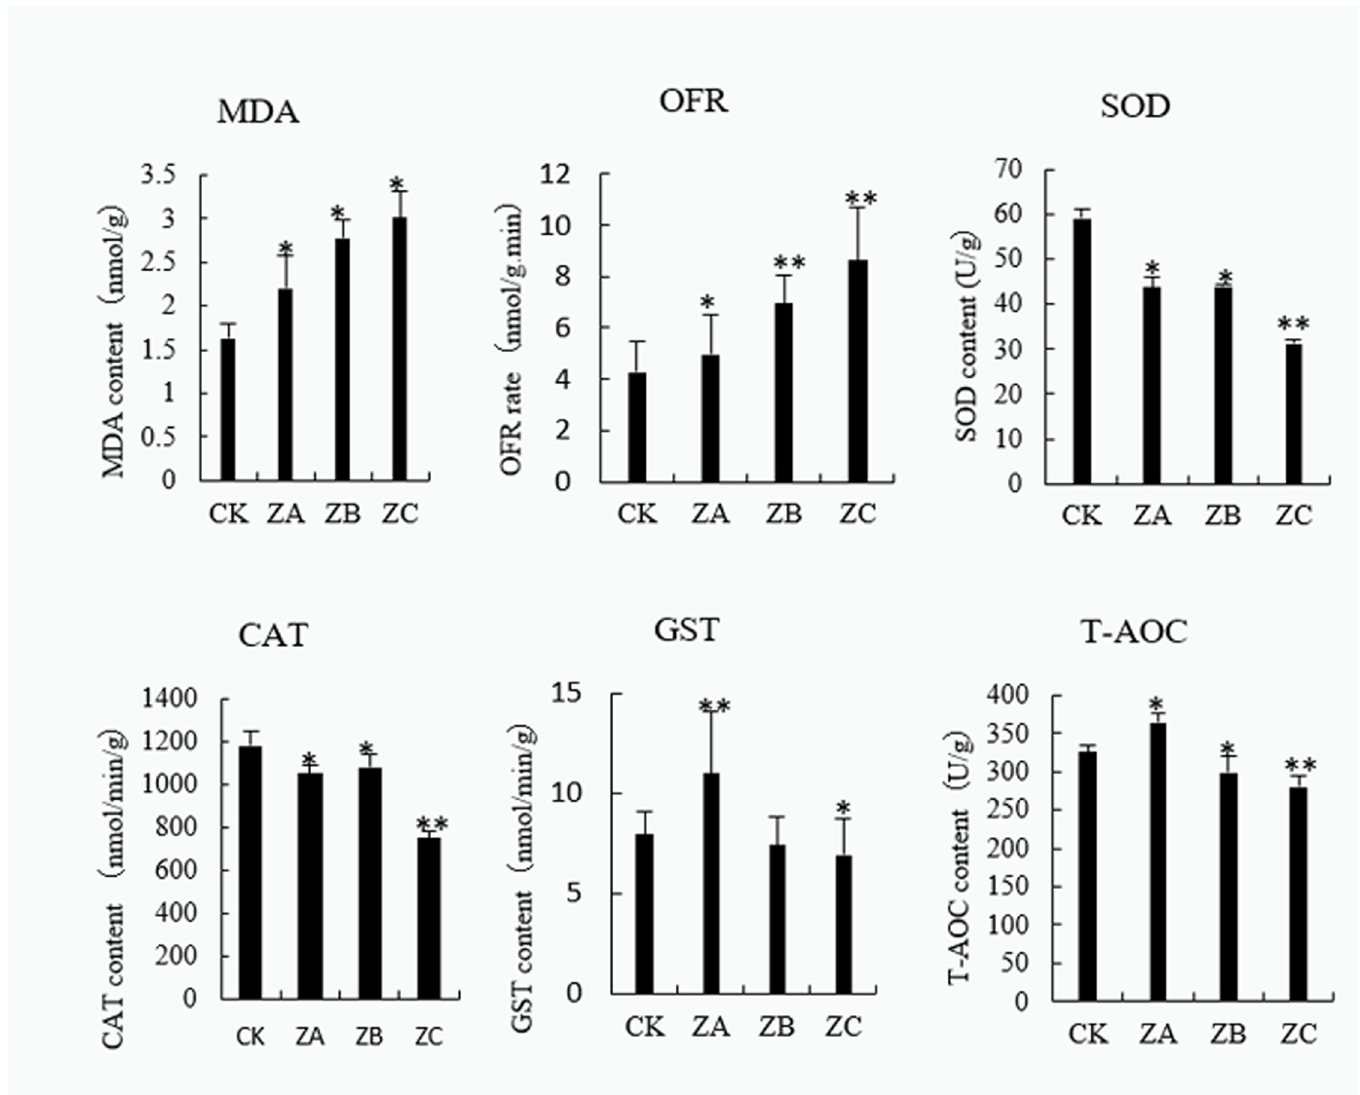
Fig 3. Determination of physiological indicators. Note: � : 0.01 < P � 0.05, �� : 0 < P �